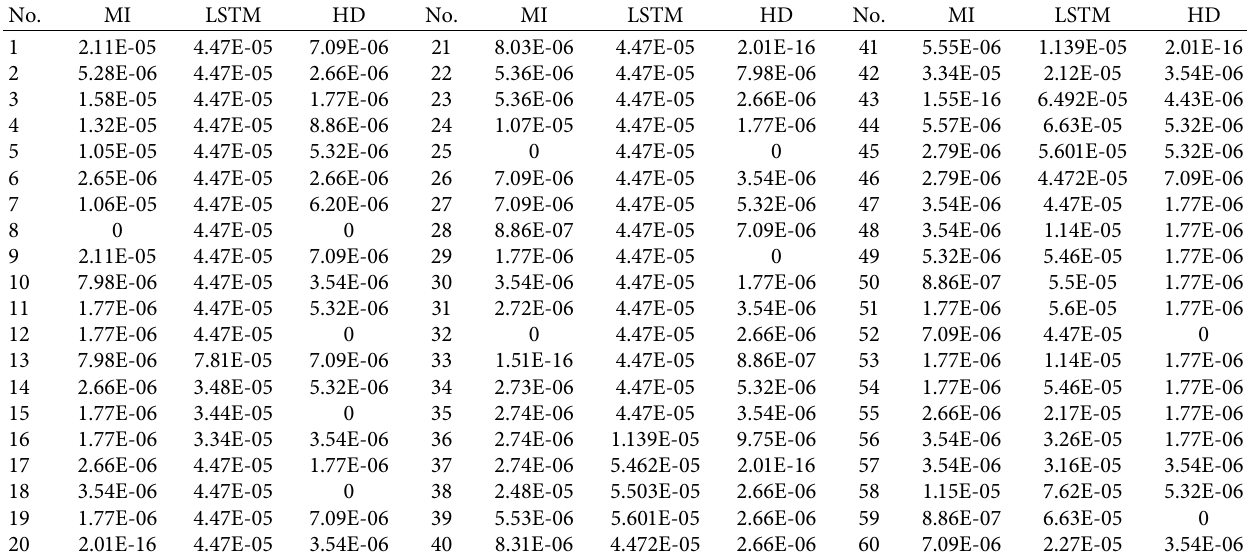
Table 2: (Attached table) Comparison of the filling error rates for missing data in outlet temperature of the first loop.